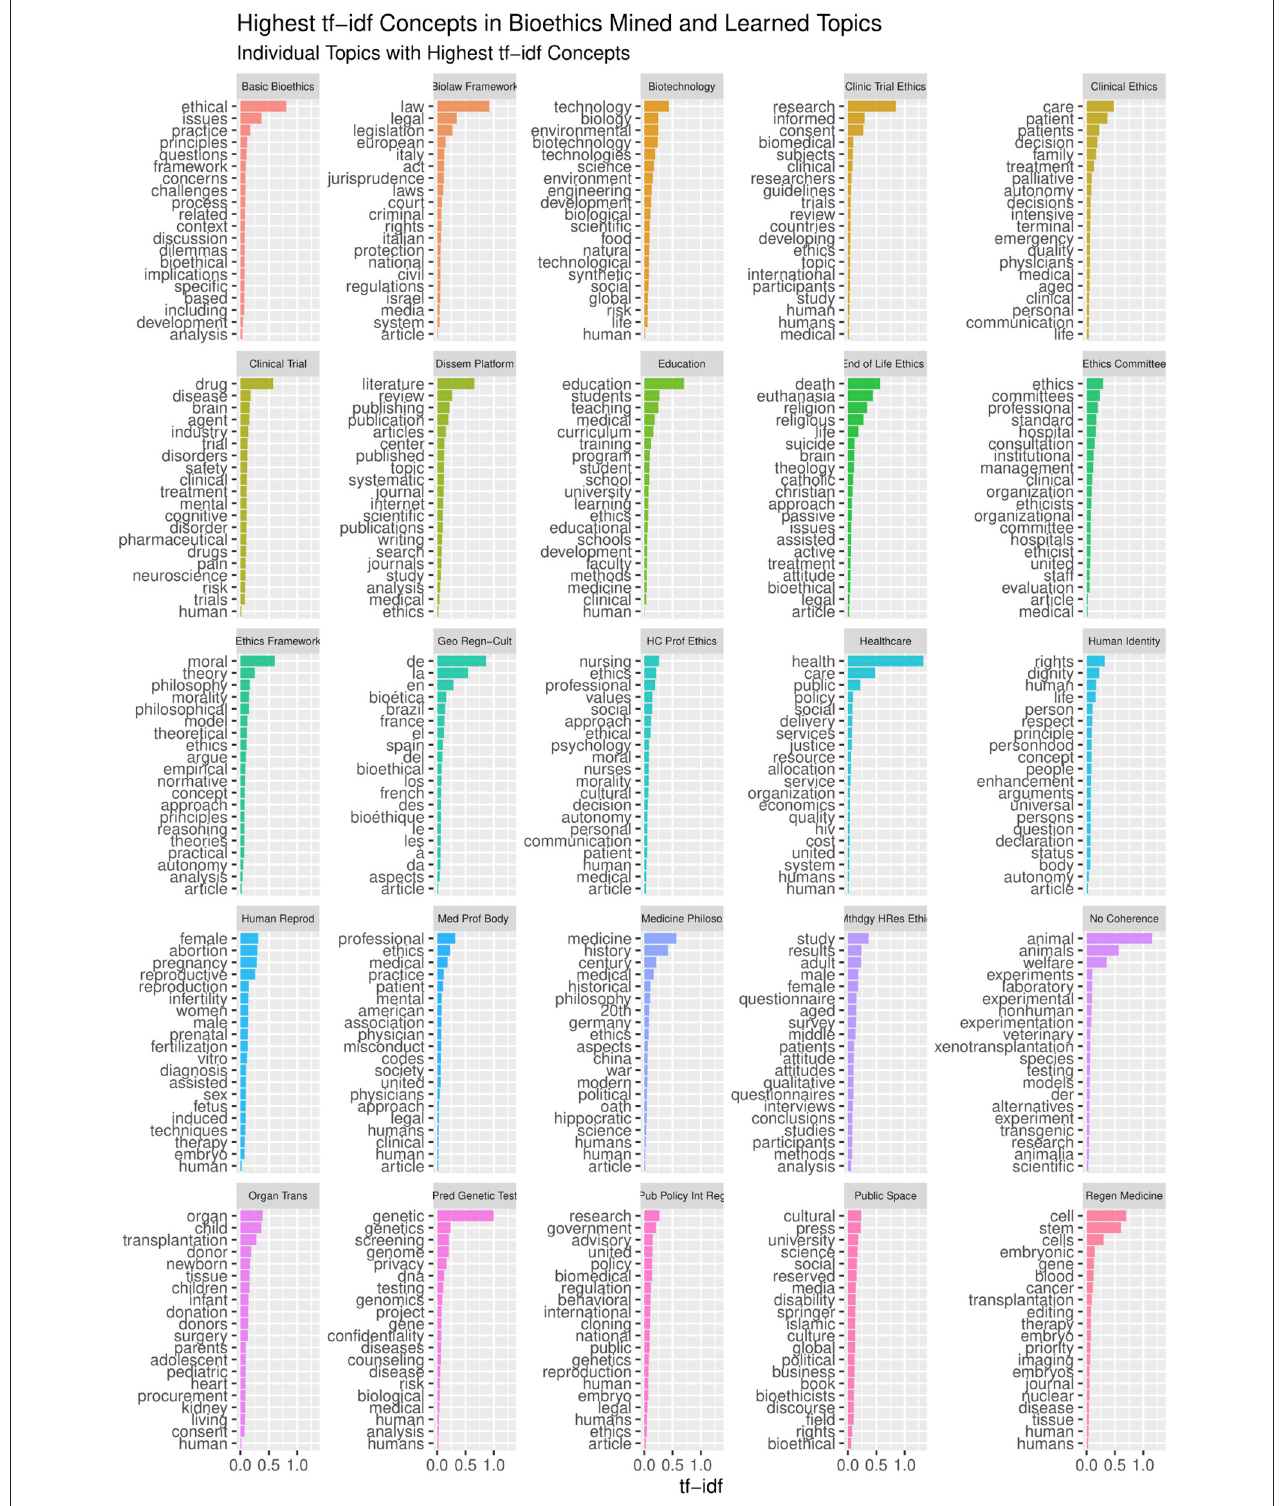
FIGURE 6 | Each ontological topic with varying levels of statistical significance.